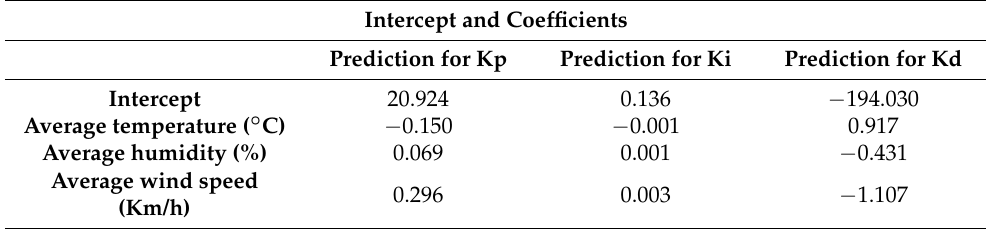
Table 5. Intercept and coefficients of the multiple linear regression